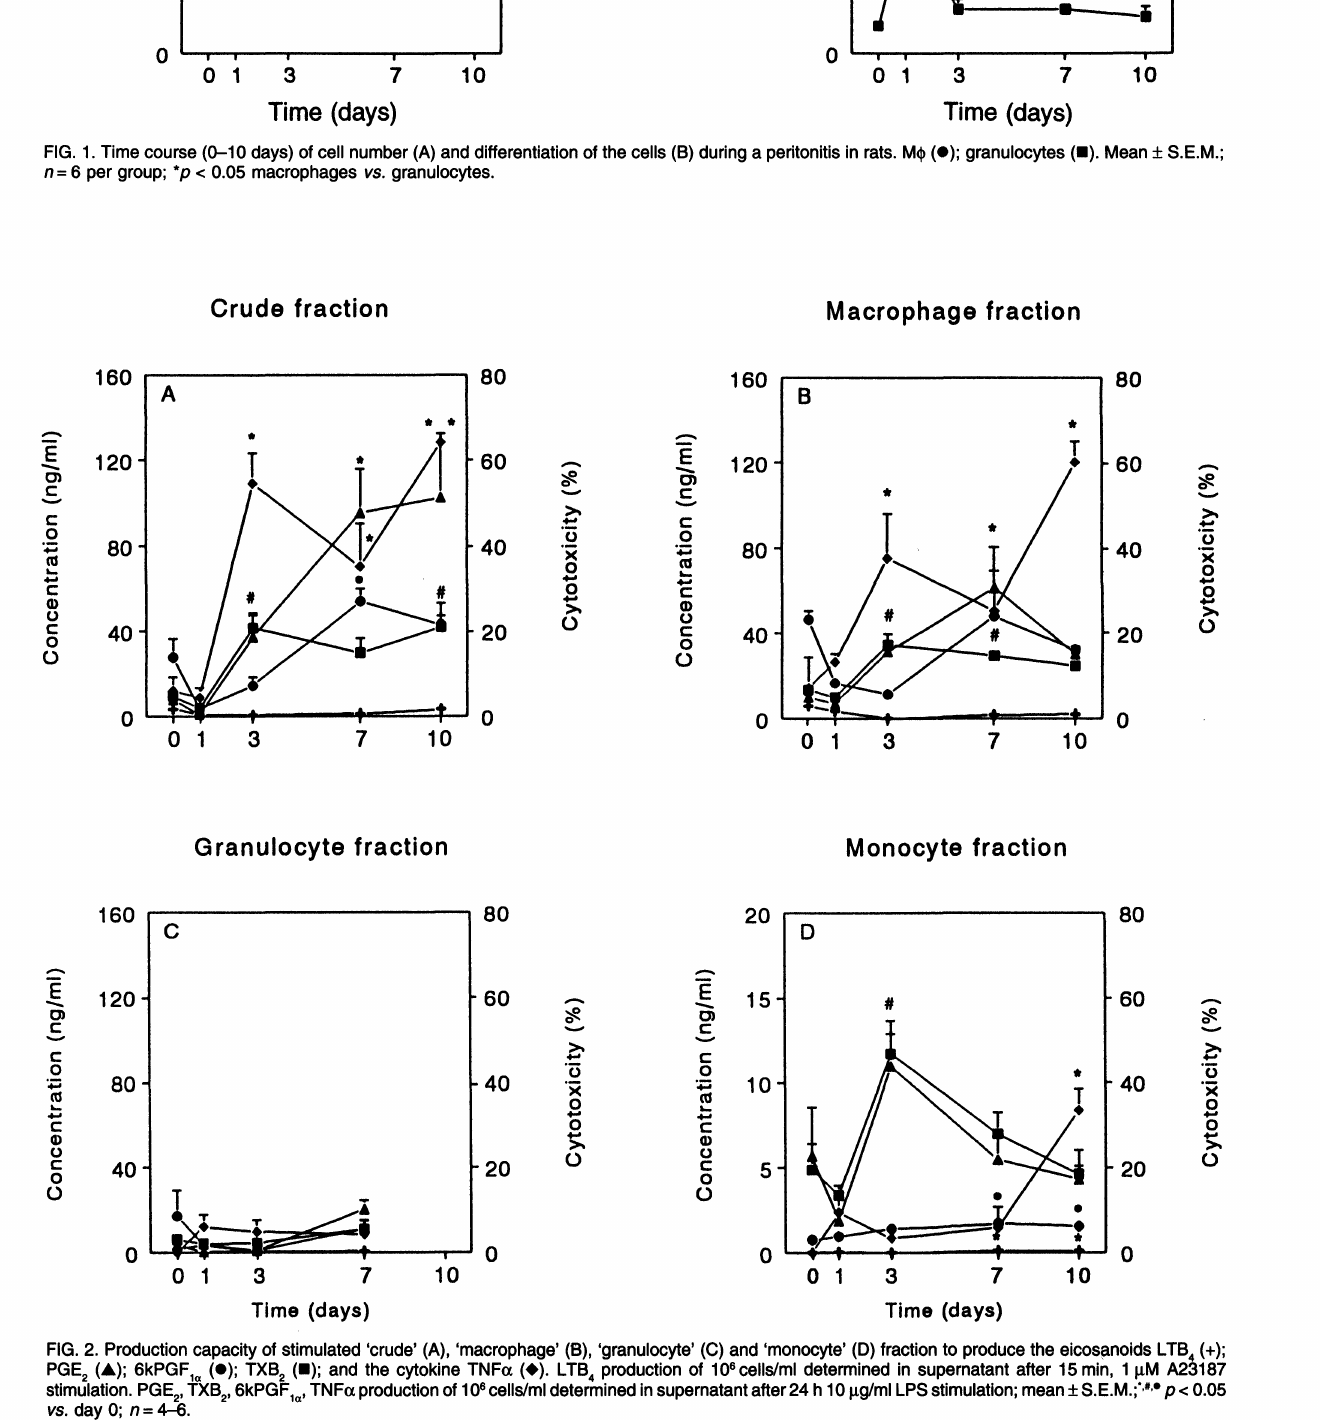
FIG. 1. Time course (0-10 days) of cell number (A) and differentiation of the cells (B) during a peritonitis in rats. M (e); granulocytes (e). Mean + S.E.M.; n 6 per group; *p < 0.05 macrophages vs. granulocytes.